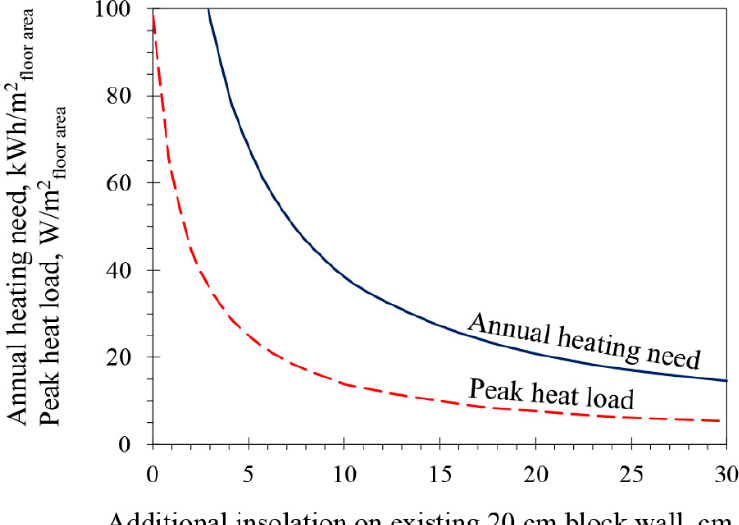
Figure 2. The decrease of annual heating energy need and peak heat power need per square meter heated floor area using increased mineral wool insulation [41].